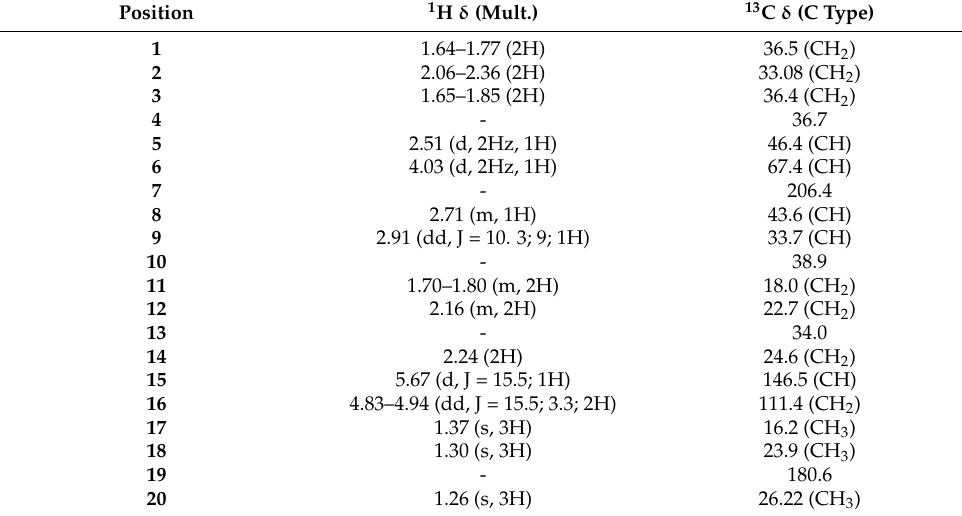
Table 1. 1 H and 13 C NMR data of compound 10